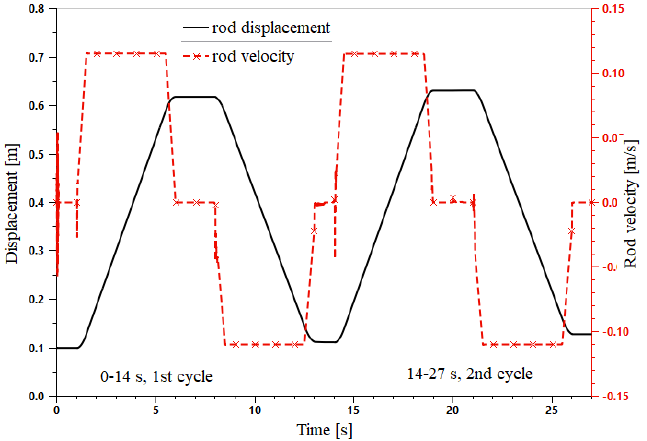
Figure 8. Rod velocity and displacement curves of boom cylinder in the original system.